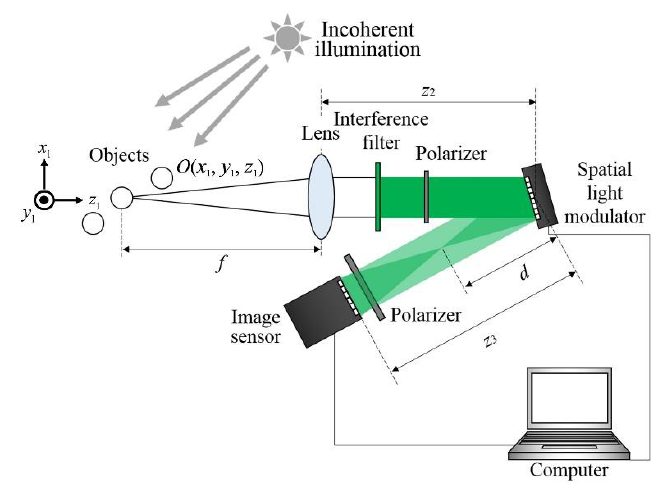
Figure 4. An optical setup of Fresnel incoherent correlation holography (FINCH).